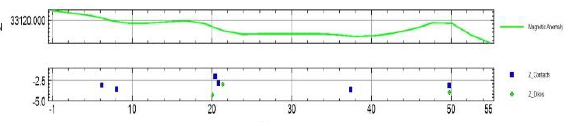
Figure 15: Total magnetic intensity profile for traverse 1 location1